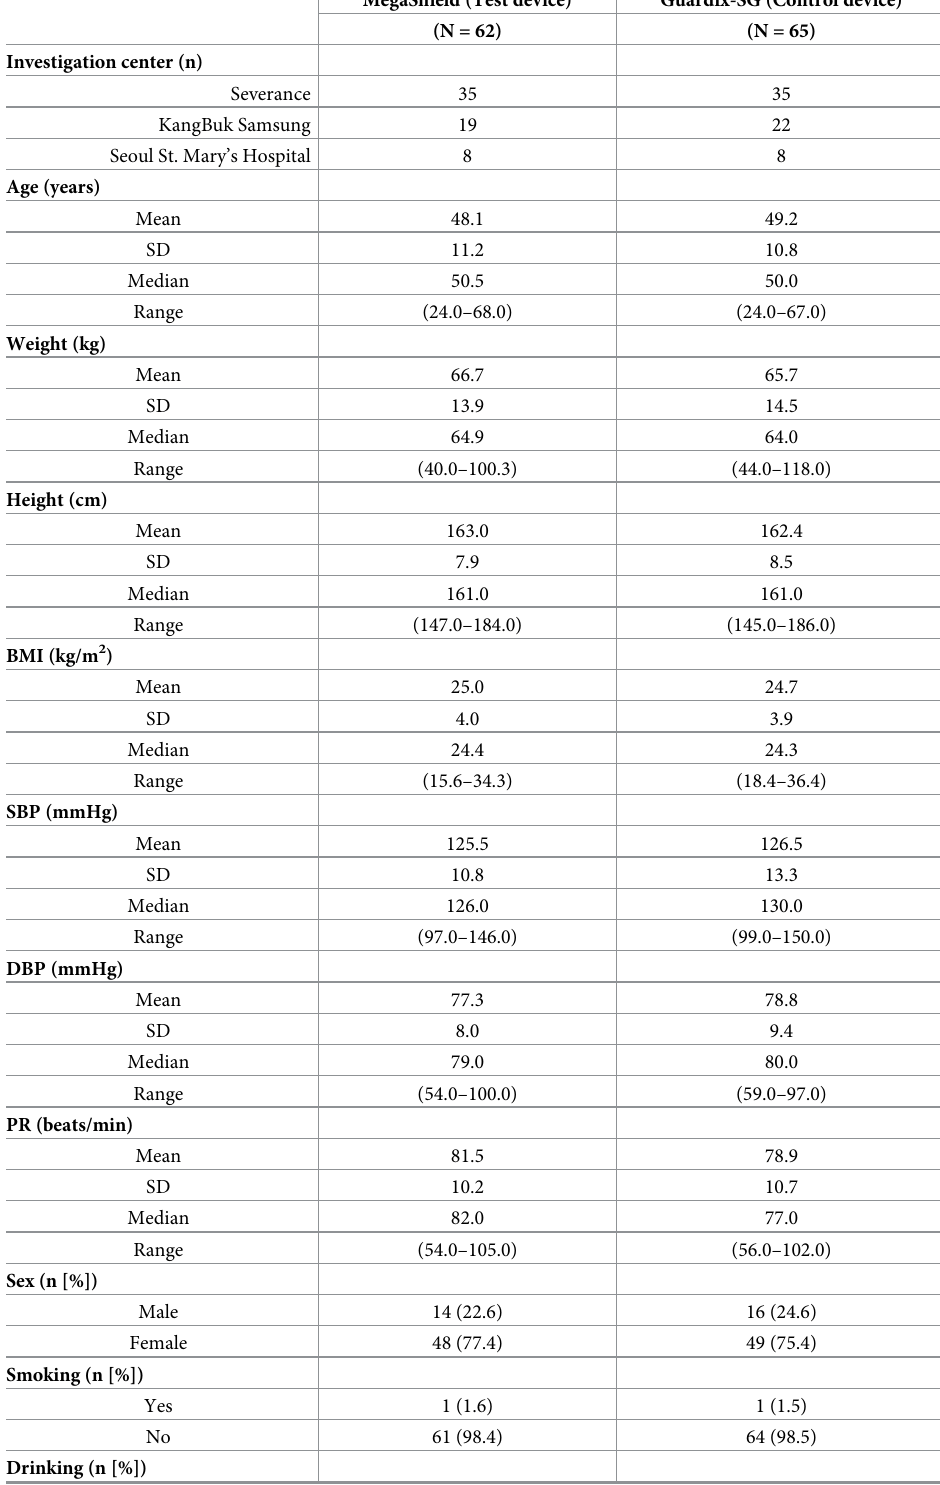
Table 3. Demographic and baseline characteristics (ITT